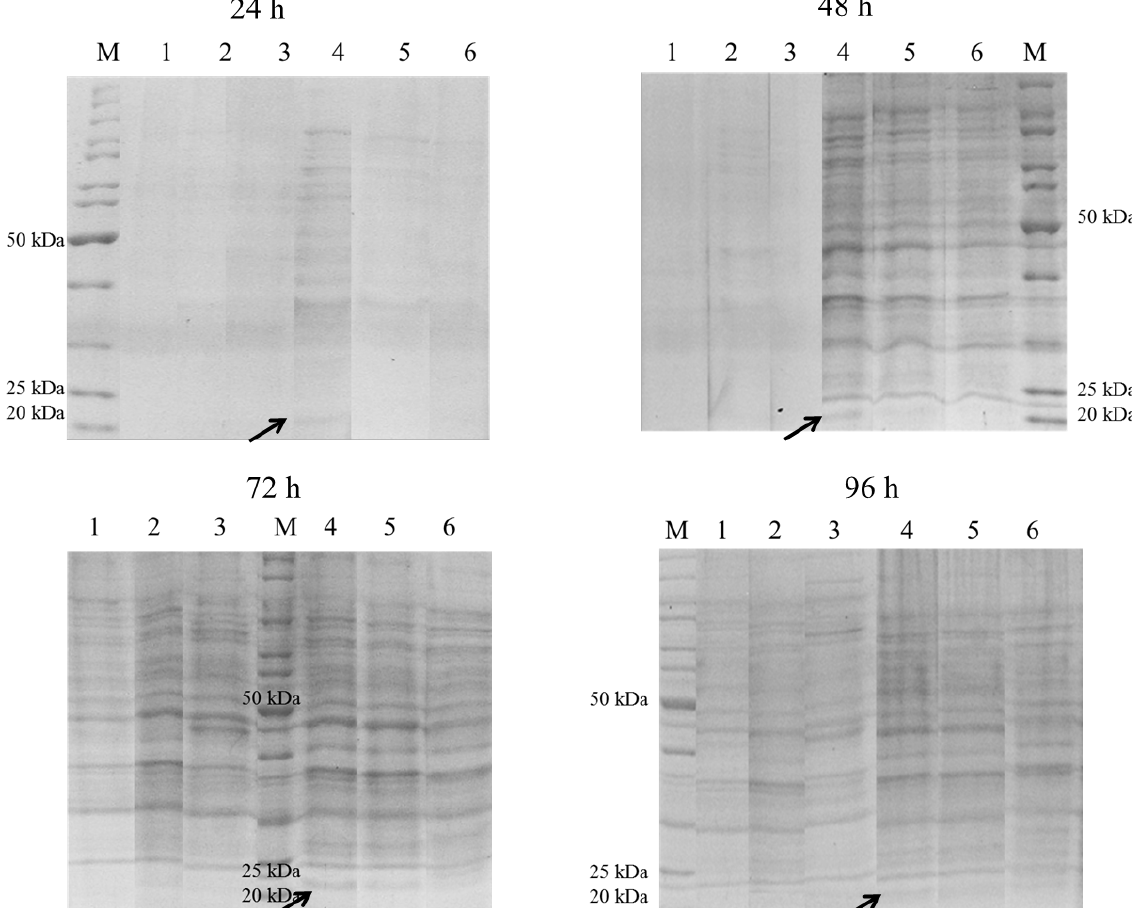
FIGURE 3 - SDS-PAGE analysis of INF-β-1a expression at different time intervals (24 h, 48 h, 72 h, 96 h) for culture supernatant of recombinants 1, 2, 5, 11, 16 and 17 (lane 1-6). M: Protein markers (kDa). The expressed INF-β-1a (22 kDa) was indicated by the